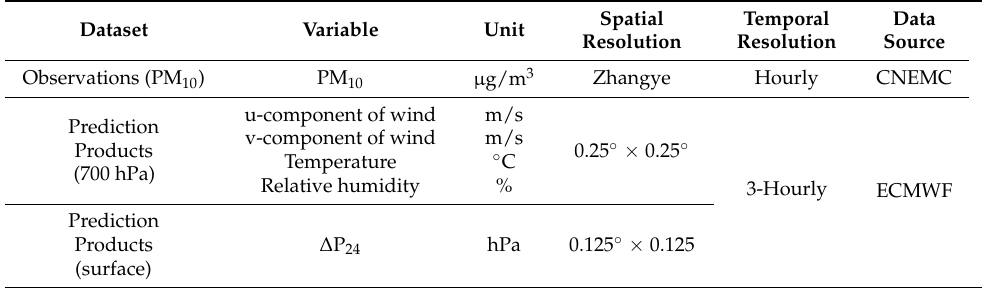
Table 3. Selection of machine learning eigenvalues for PM 10 concentration prediction in Xining